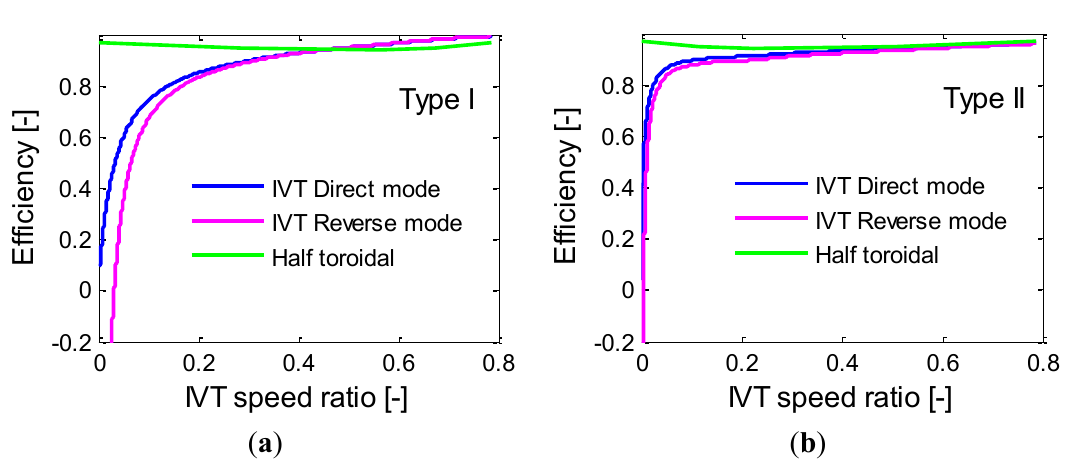
Figure 6. Overall speed ratio and efficiencies for ( a ) Type I and ( b ) Type II IVTs in direct and reverse